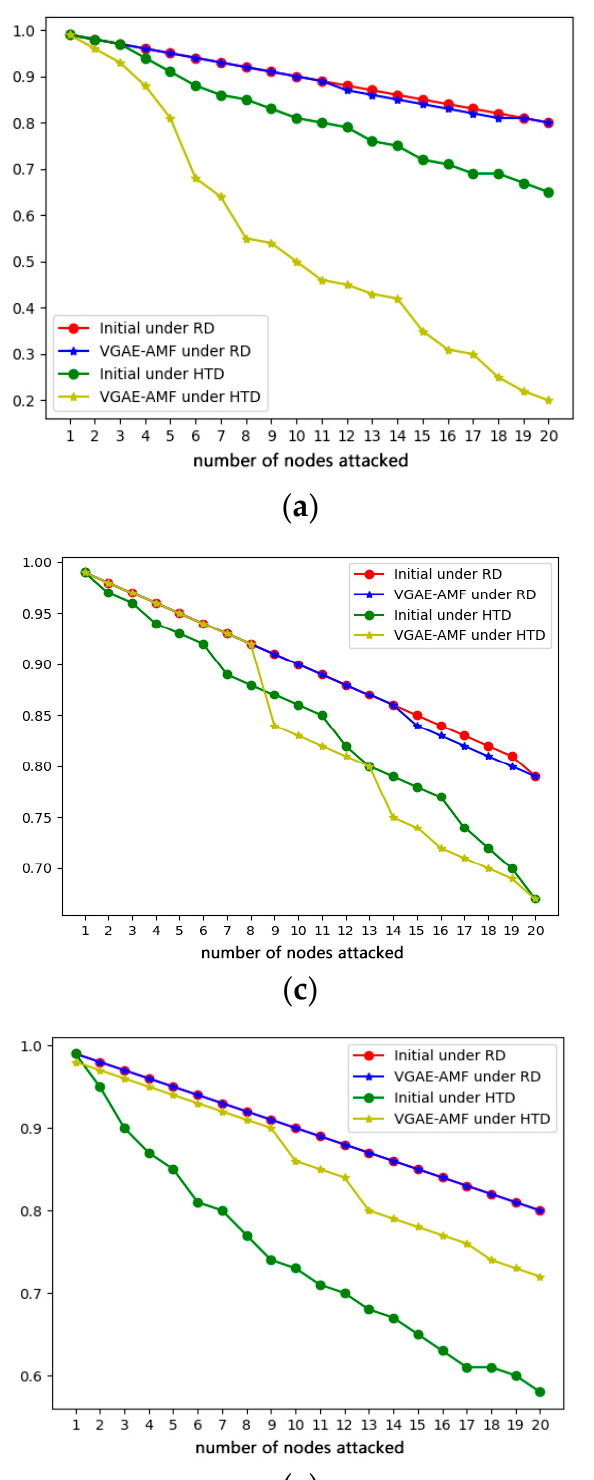
Figure 9. Effect of different values c on algorithm optimization: ( a ) c = 0.1; ( b ) α = 0.3; ( c ) α =